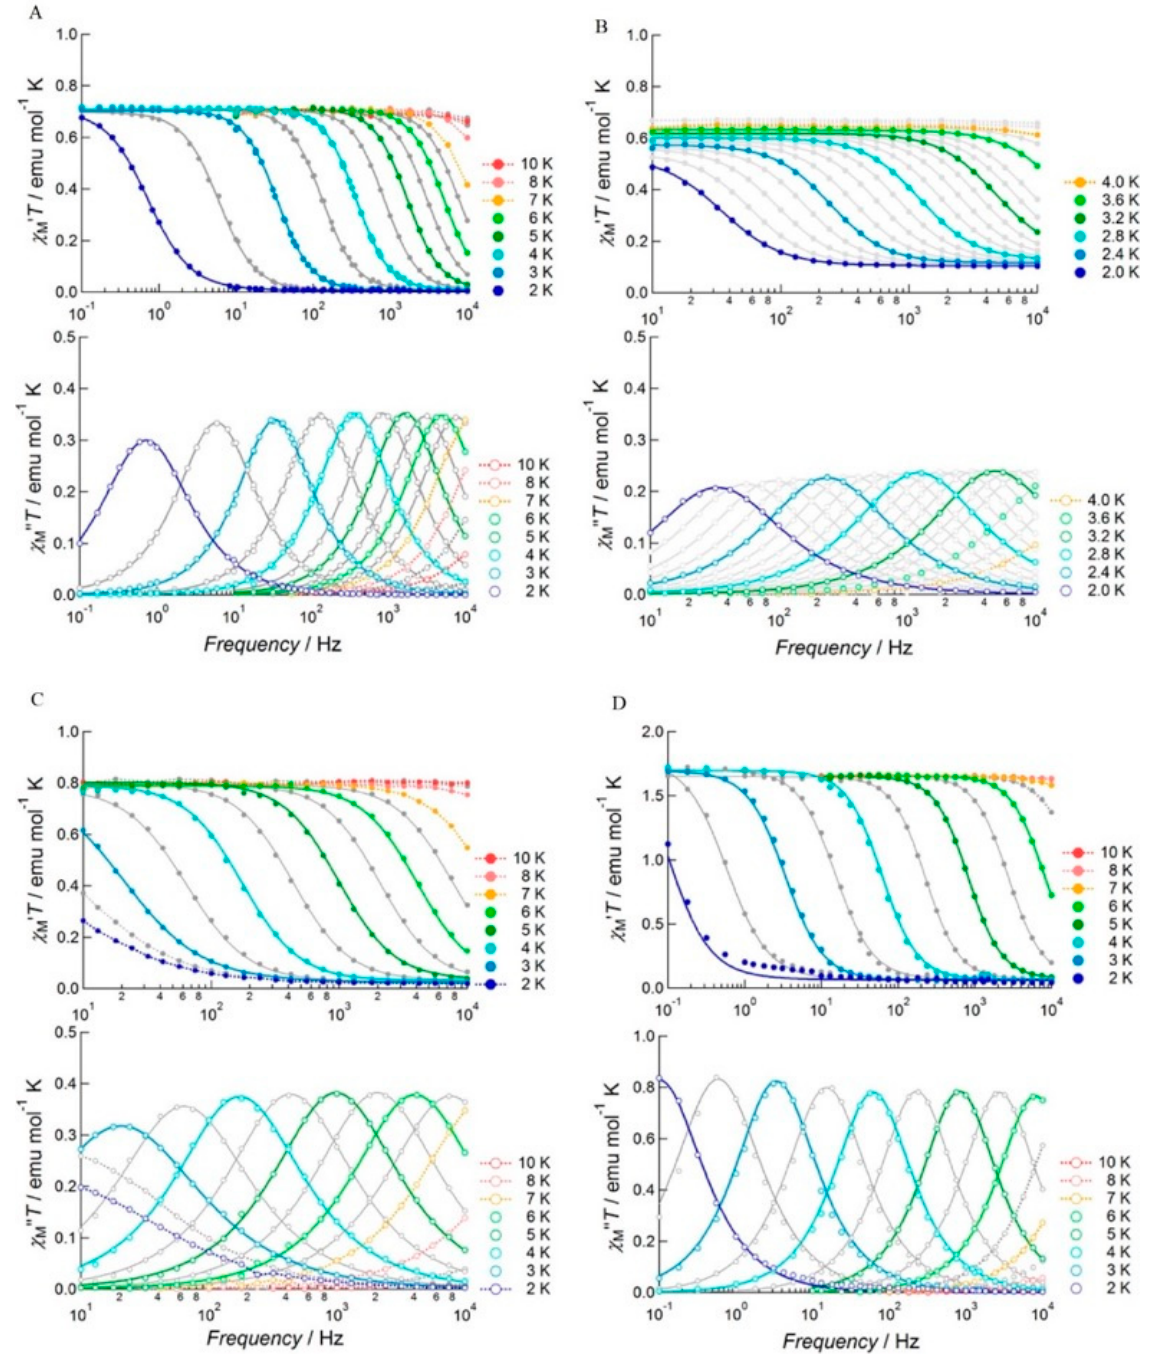
Figure 26. In-phase and out-of-phase susceptibility peak maxima for 41 ( A ); 43 ( B ); 44 ( C ); and 46 ( D ) at an applied field of 1000 Oe. Figures are reproduced from Reference [63] with permission from the American Chemical Society © 2016.